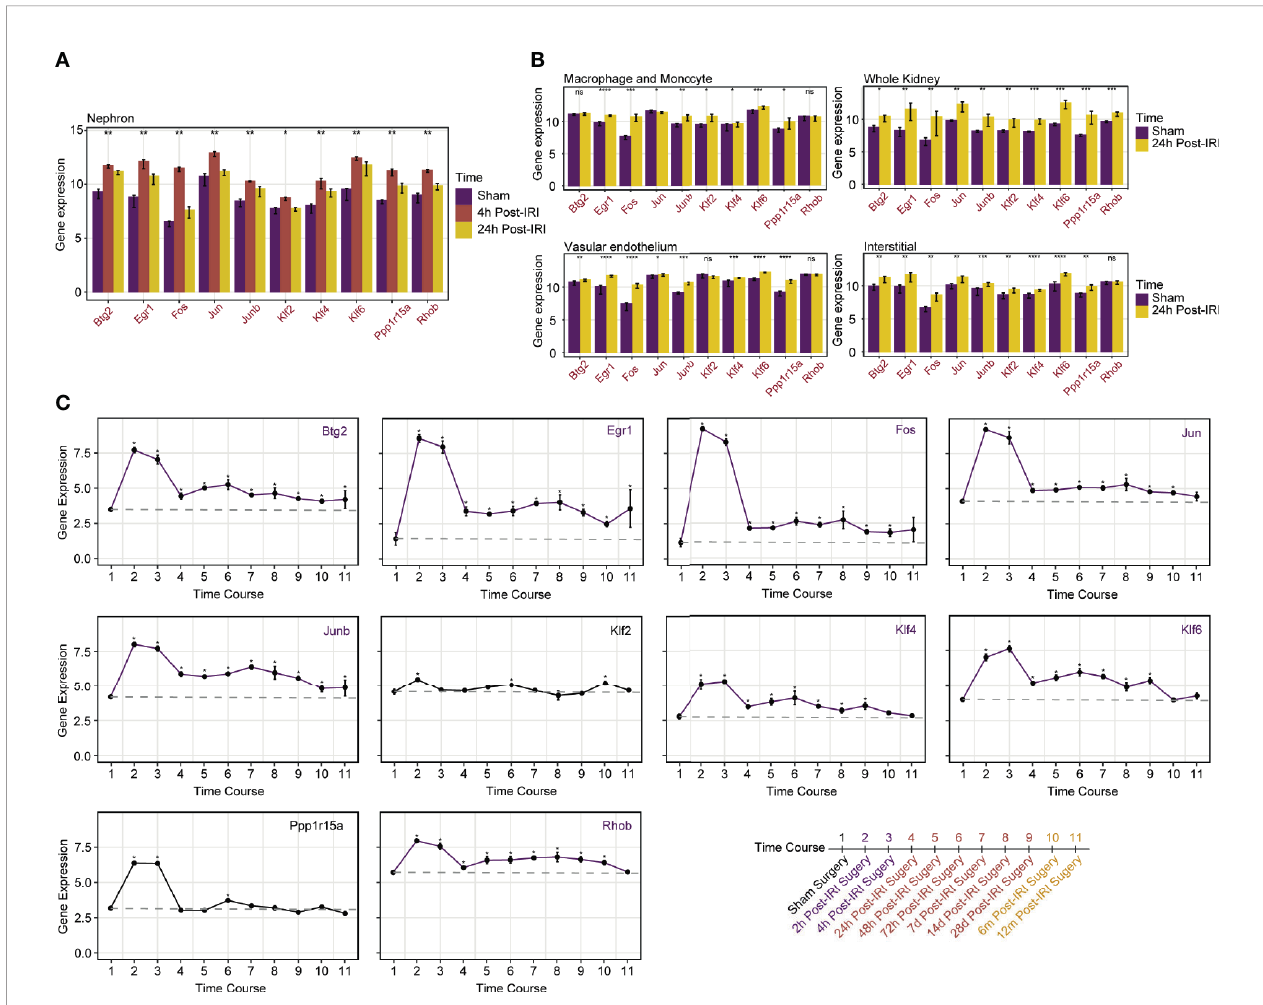
FIGURE 4 | Speci fi c cell type and time course analyses of prognostic genes in mice RIRI model. (A) Histograms represent expression levels of prognostic genes in the nephron of mice from sham and 4- and 24-h post-IRI groups. (B) Histograms compare gene expression levels between sham and 24-h post-IRI samples of macrophage and monocyte, vascular endothelium and interstitial, and whole kidney. * p < 0.05; ** p < 0.01; *** p < 0.001; **** p < 0.0001; ns, not statistically signi fi cant. (C) Line plots with 95% con fi dence intervals show changes in expression levels of prognostic genes over time post-IRI; a total of 10 different time points were included in analyses as illustrated on the bottom-right side of the picture. Genes marked in purple kept higher expressed than baseline until 12 months after